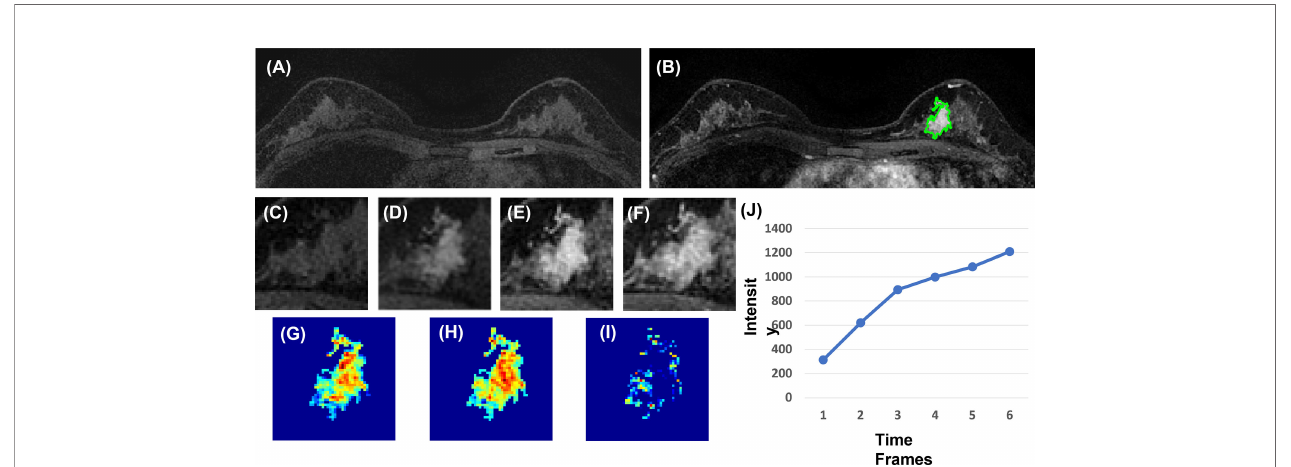
FIGURE 4 | A 40-year-old patient with benign adenosis. (A) F1 pre-contrast image. (B) The F2 post-contrast image. (C) F1 pre-contrast. (D) F2 post-contrast. (E) F3 post-contrast. (F) The last F6 post-contrast image, showing persistent enhancement with increased intensity over time. (G) The wash-in signal enhancement map F2 – F1.